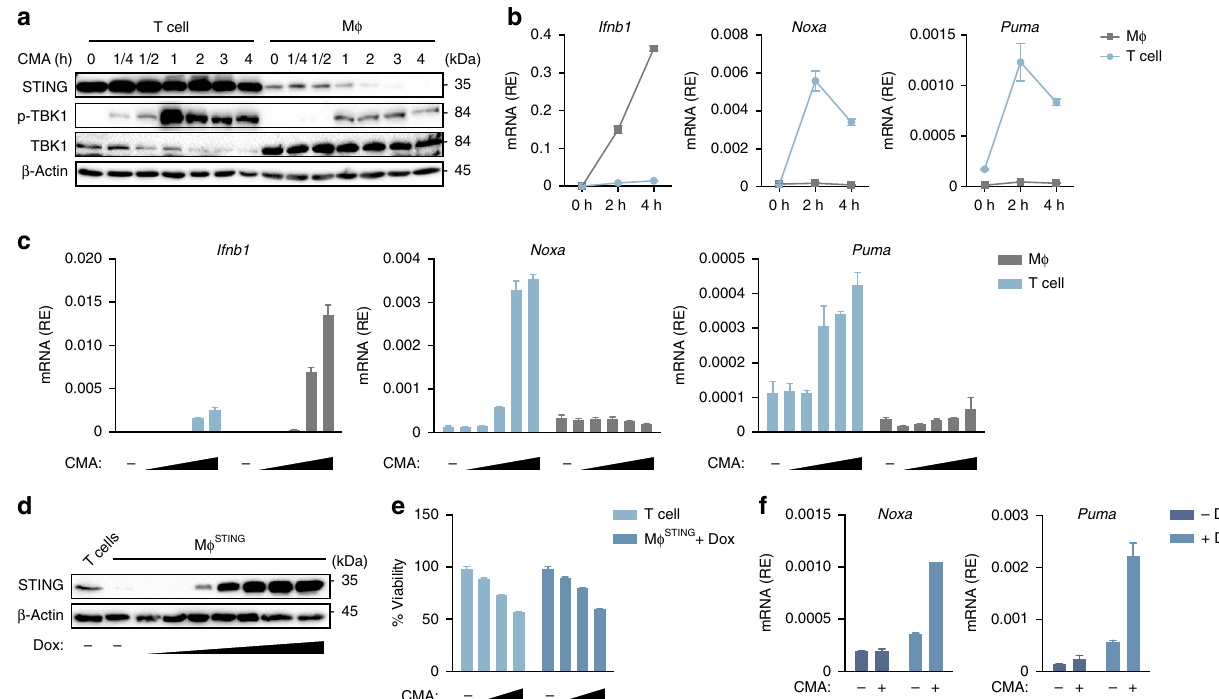
Fig. 5 Intensi fi ed STING signalling leads to apoptosis in T cells. a Wild-type (WT) CD4 + T cells and bone marrow-derived macrophages (M Φ ) were left untreated or stimulated with 10-carboxymethyl-9-acridanone (CMA) for the indicated time points and immunoblot analysis was performed with indicated antibodies. b WT CD4 + T cells and macrophages were stimulated with CMA for 2 h and 4 h, followed by quanti fi cation of abundance of mRNAs for the indicated genes by RT-qPCR. c WT CD4 + T cells and macrophages were stimulated with increasing doses of CMA (31.25 – 250 μ g/ml) and upregulation of depicted genes was determined by RT-qPCR. d Macrophages transduced with a doxycycline-inducible murine STING construct (M Φ STING ) were treated with doxycycline and STING expression was determined by immunoblot. e WT CD4 + T cells and M Φ STING were treated with CMA and cell viability was assessed by CellTiter Blue assay. f M Φ STING in the presence or absence of doxycycline were treated with CMA and proapoptotic gene expression was assessed by RT-qPCR. Data are representative of three independent experiments a , d or mean and s.d. of technical replicates of one representative experiment out of n = 3 independent experiments are shown b , c , e , f . Unprocessed original blots are shown in Supplementary Fig.